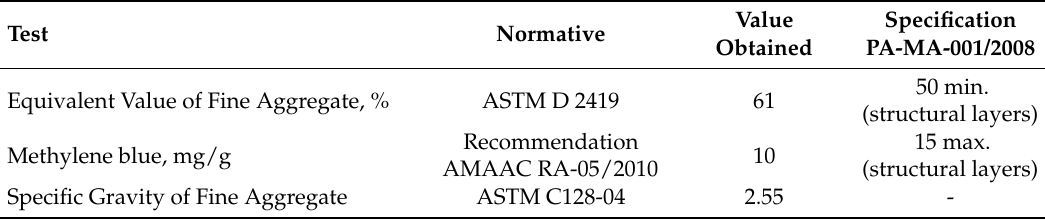
Table 2. Characteristics of the fine